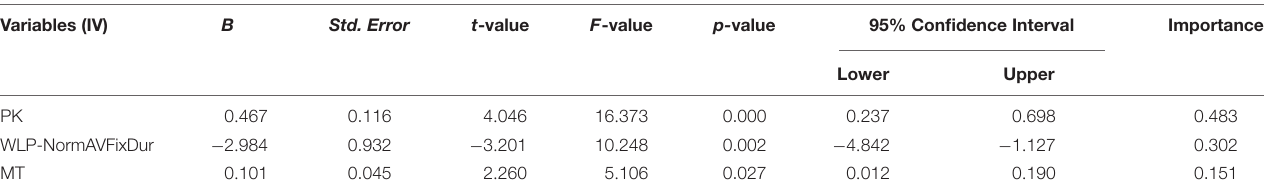
TABLE 4 | Automatic linear modeling results for the WLP tests.